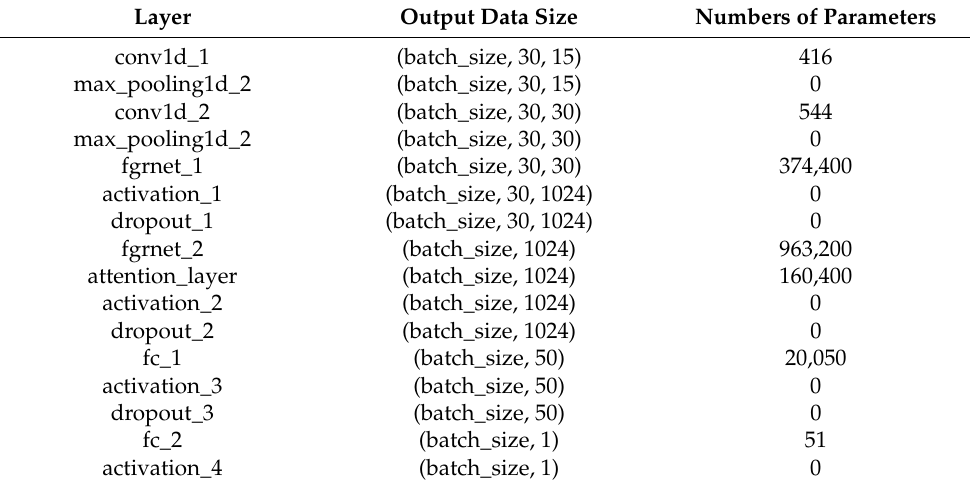
Table 10. Structure of AM-FGRNET based on FD001.